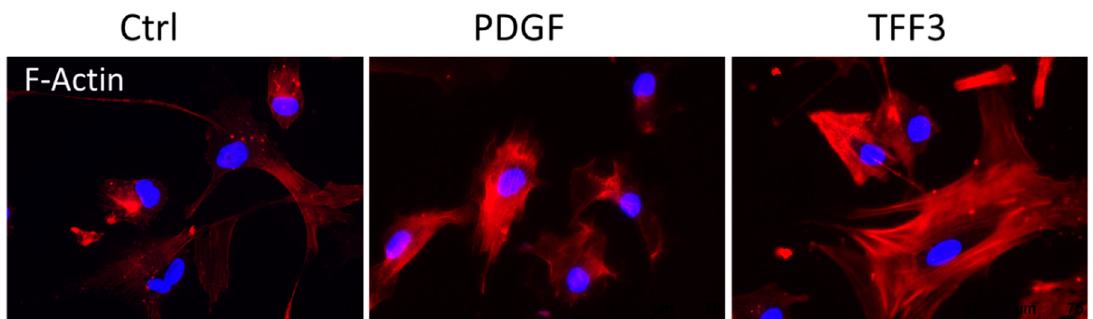
Figure 6. Effect on F-Actin cytoskeleton. Conjugated phalloidin visualizes changes on the F-Actin cytoskeleton. Stimulation by Platelet derived Growth Factor (PDGF) and TFF3 lead to reorganized F-Actin with more prominent stress fibers compared to control.